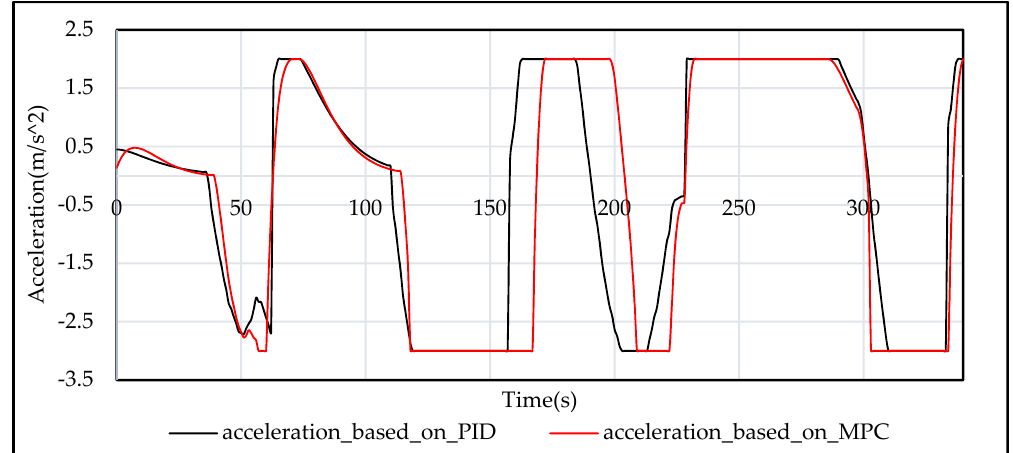
Appl. Sci. 2020 , 10 , x FOR PEER REVIEW Figure 8. Acceleration response in scenario 1. Figure 8. Acceleration response in scenario 1 . Figure 8. Acceleration response in scenario 1 .